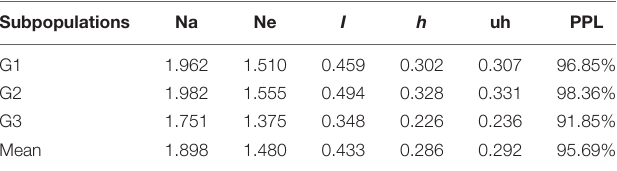
TABLE 4 | Mean of different genetic parameters including number of different alleles (Na), number of effective allele (Ne), Shannon’s index ( I ), diversity index ( h ), unbiased diversity index (uh), and percentage of polymorphic loci (PPL) in each subpopulation of the 230